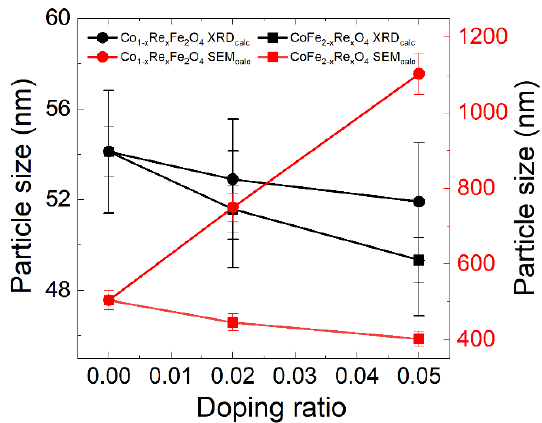
Figure 4. Grain size of the Co 1 − x Re x Fe 2 O 4 and CoFe 2 − x Re x O 4 samples calculated from the XRD and SEM result. The particle size is more than 10 times larger than the grain